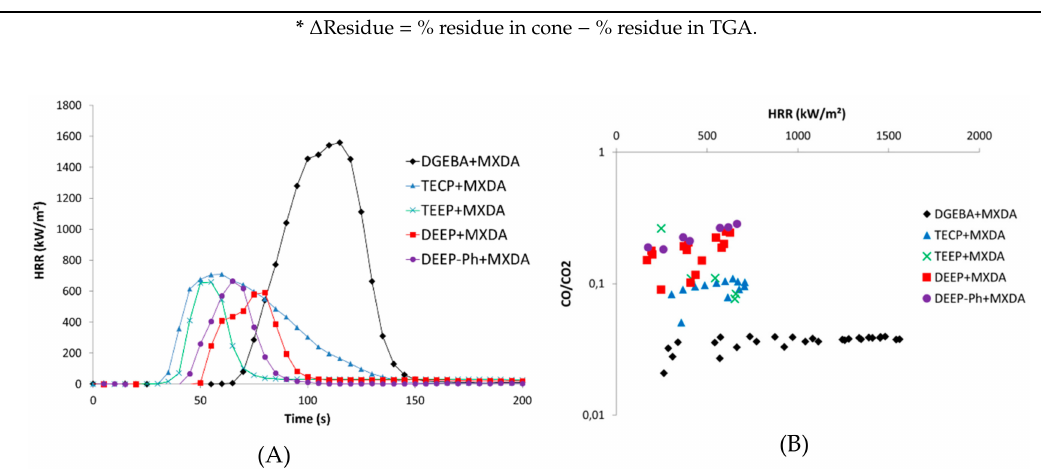
Figure 7. ( A -left) Heat release rate versus time. ( B -right) CO / CO 2 ratio versus HRR in cone calorimeter